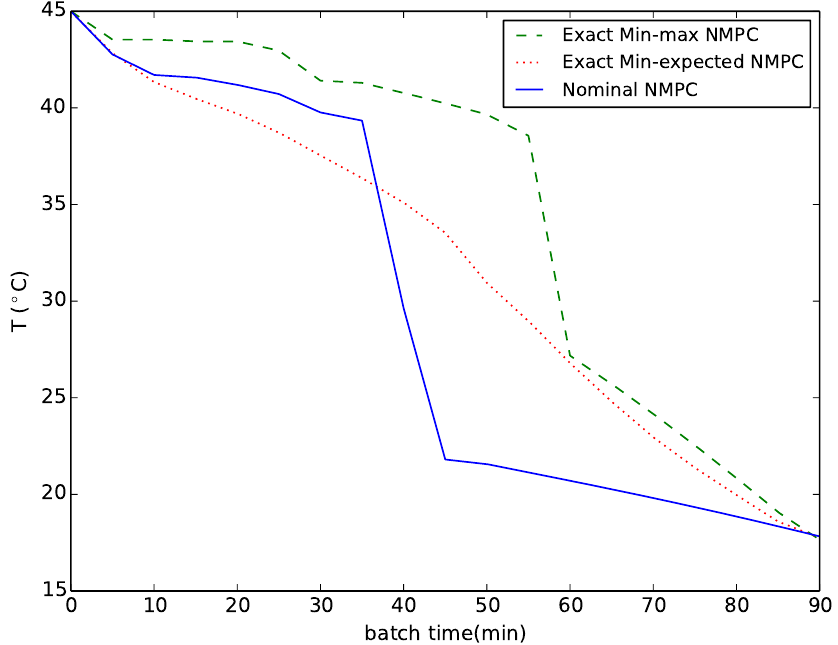
Figure 1. Optimal temperature profile for nominal NMPC (nonlinear model predictive control) and robust